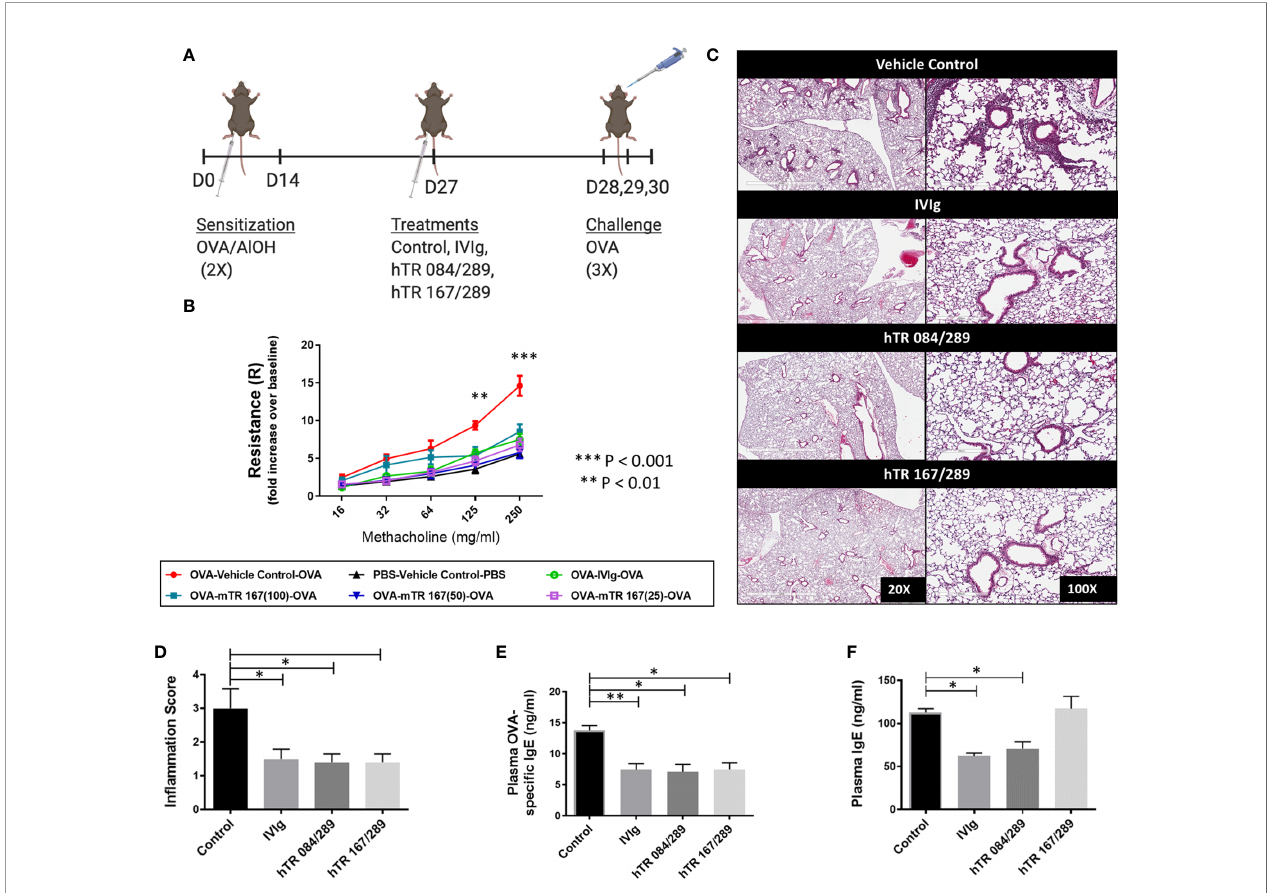
FIGURE 1 | Tregitopes improve OVA-driven murine allergic airways disease. When compared to IVIG, IgG Tregitopes were equally as effective at reducing airway disease. (A) Timeline of the OVA-driven model of murine allergic airways disease used in this experiment. Sensitization to OVA/AlOH was performed on days 0 and 14. Treatment with Control, IVIg and Tregitopes was administered on day 27. Challenge was done intranasally with OVA on days 28, 29 and 30. (B) Airway hyperresponsiveness to methacholine was performed on day 31 (2 independent experiments, n = 3). (C) Representative images of formalin- fi xed lung slides stained with H&E and (D) associated in fl ammation scores for the Control, IVIg, hTR 084/289 and hTR 167/289 treatment groups (2 independent experiments, n = 4-5). Two pathologists, blinded to the study, assessed and graded the slides for peri-bronchial in fl ammation and quality of cell in fi ltrates. For each group 8-10 slides from 4-5 animals were used in the evaluation. (E) OVA-speci fi c IgE in plasma and (F) Total IgE, measured by ELISA. ***p, 0.005, **p, 0.01, *p, 0.05, one-way ANOVA